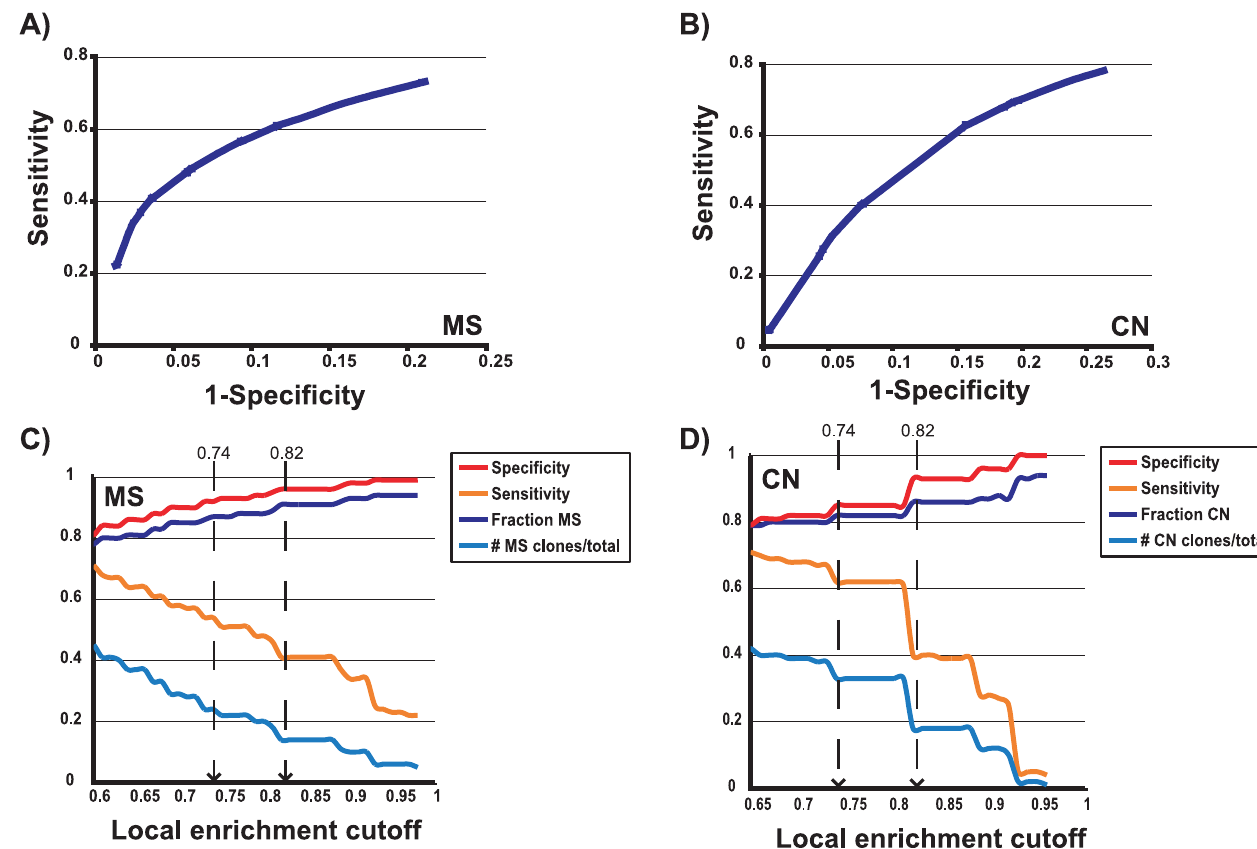
Figure 2. Large-Scale Categorization of MS and CN Genes We evaluated the ability of various array element-specific parameters to classify genes encoding MS (A) or CN (B) proteins, using receiver operator analysis. Based on these analyses, we chose the average log 2 Cy5/Cy3 ratio for assigning the final localization annotations (see text and Protocol S1). The curves were generated by incrementally relaxing the parameter cutoff values to generate gene sets with varying fractions of known MS- or CN- encoding genes. (C) Relationship between sensitivity, specificity, fraction of characterized genes encoding MS proteins, and the total number of clones classified as MS, using the average log 2 Cy5/Cy3 ratio as the selection criteria. The vertical arrows indicate two cutoffs used for subsequent analyses. (D) Same as in (C) but for genes encoding CN proteins. DOI: 10.1371/journal.pgen.0020011.g002